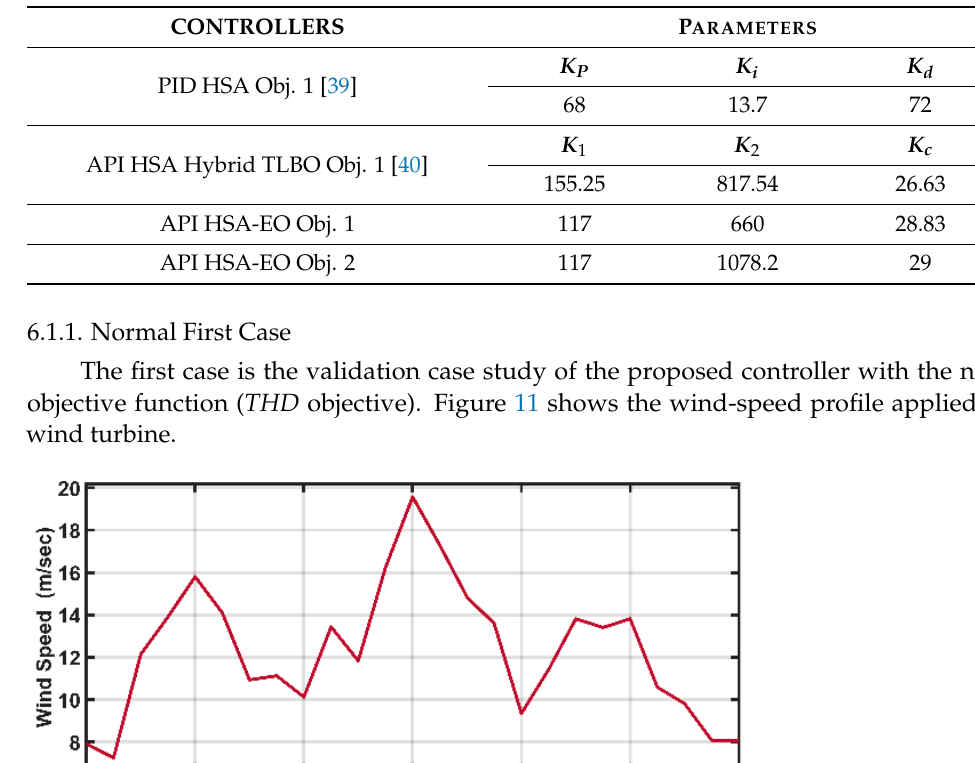
Table 1. Controller parameters in normal operation.